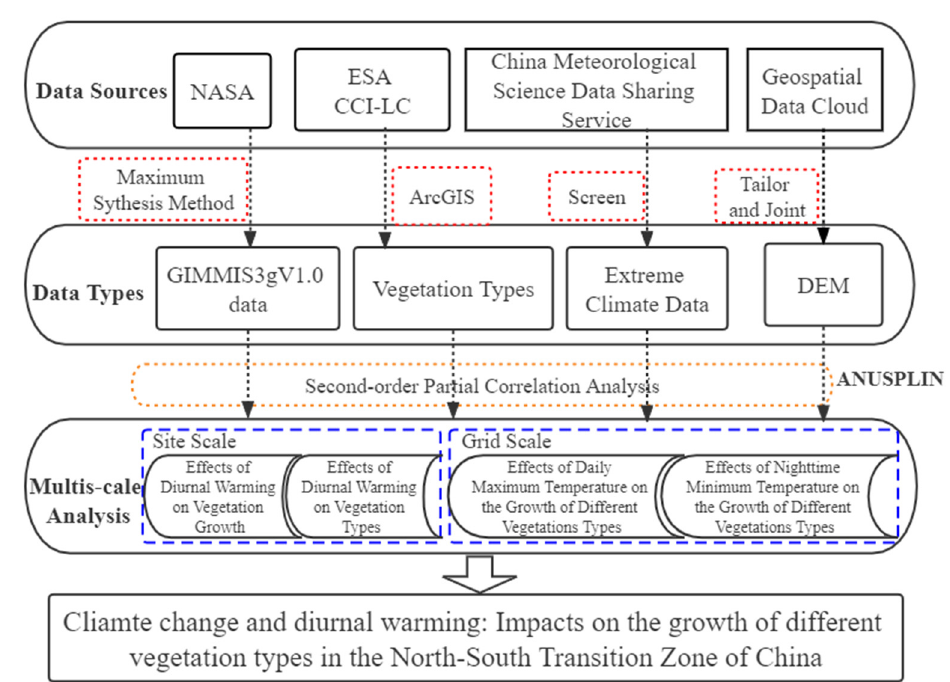
Figure 3. Research framework.